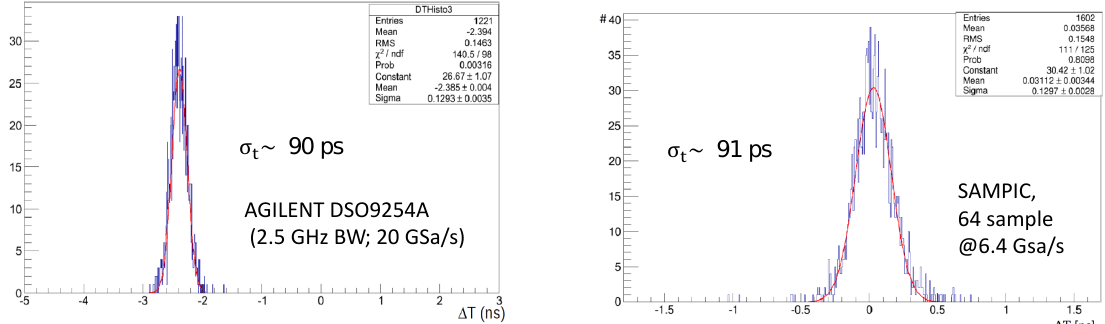
Figure 3. Time precision obtained with the oscilloscope in test beam ( left ) and with the SAMPIC in the LHC tunnel ( right ).